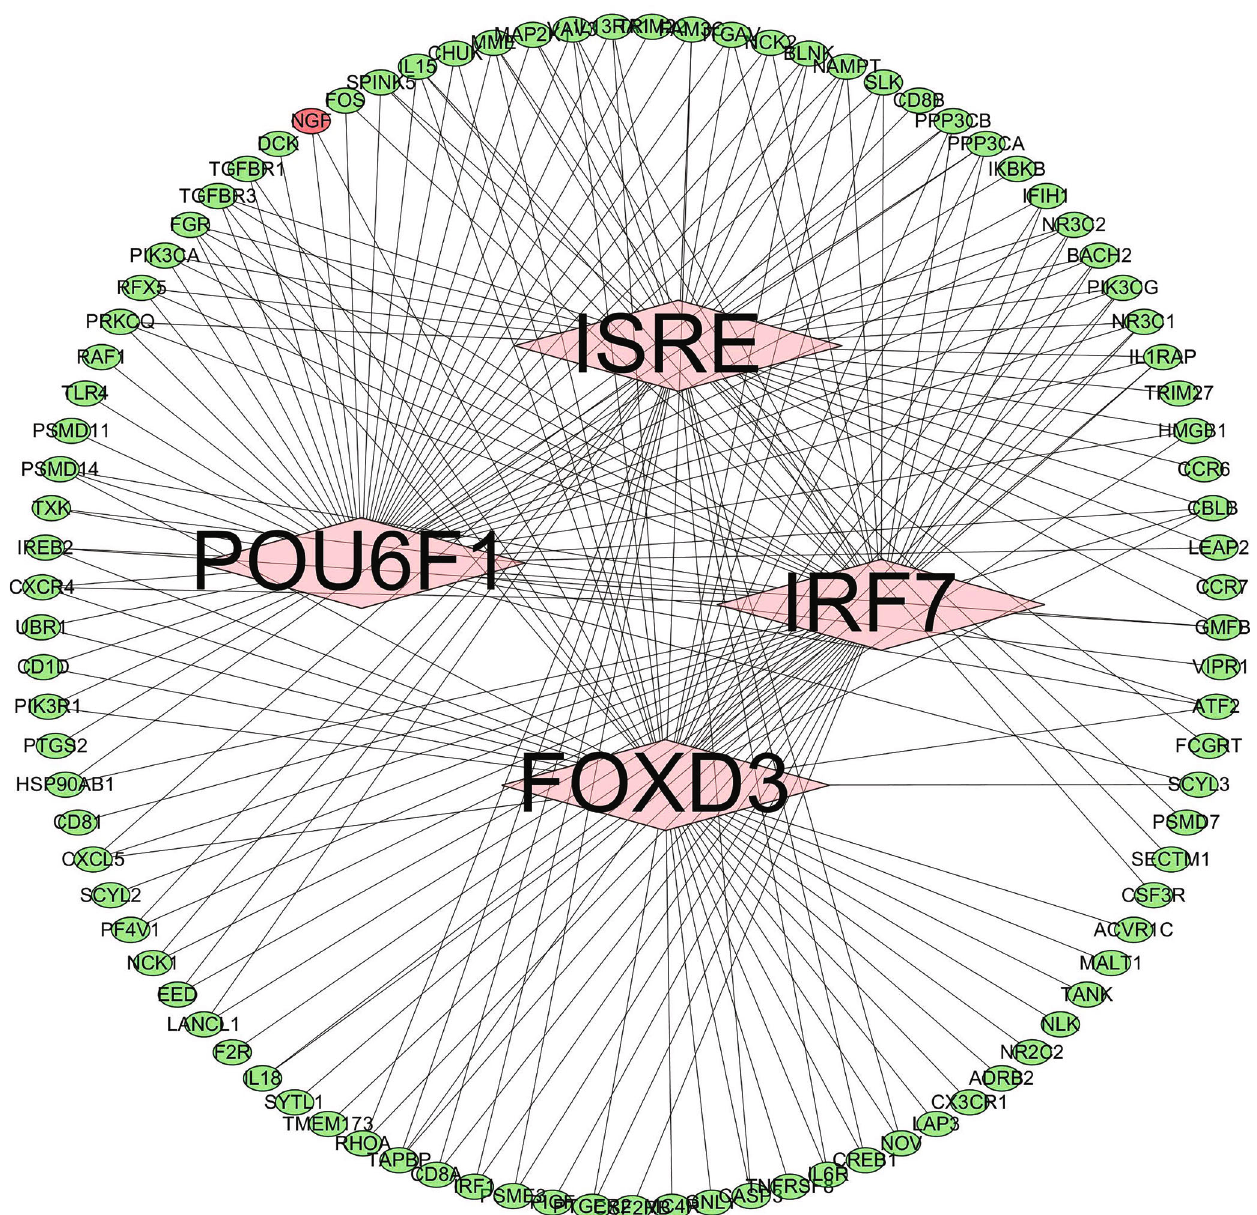
Figure 5: The regulatory network of transcription factor. The lines between two nodes mean that they have a subordinate relationship or can interact with each